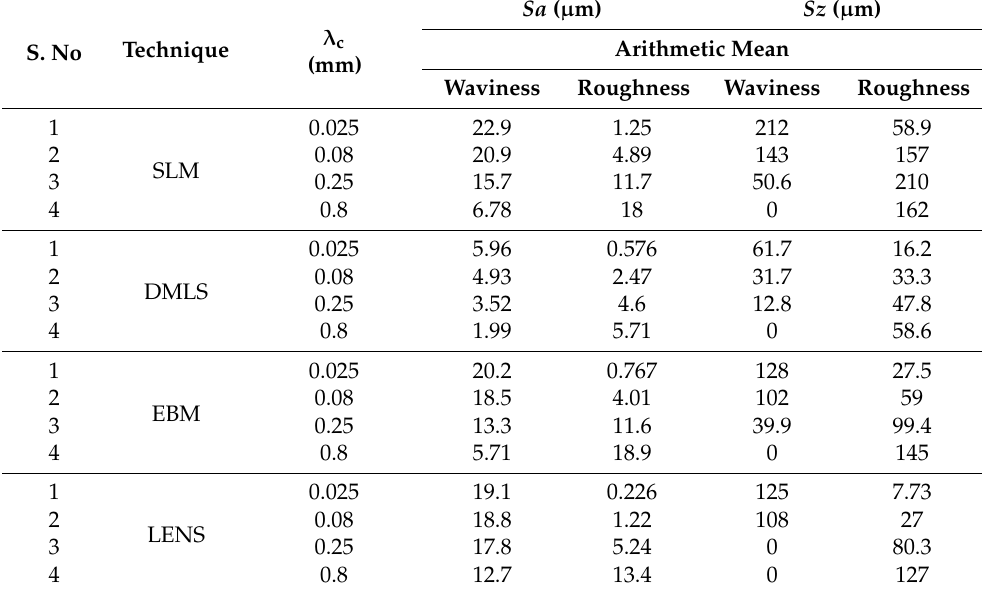
Table 5. Areal surface texture evaluation for various filtering conditions.